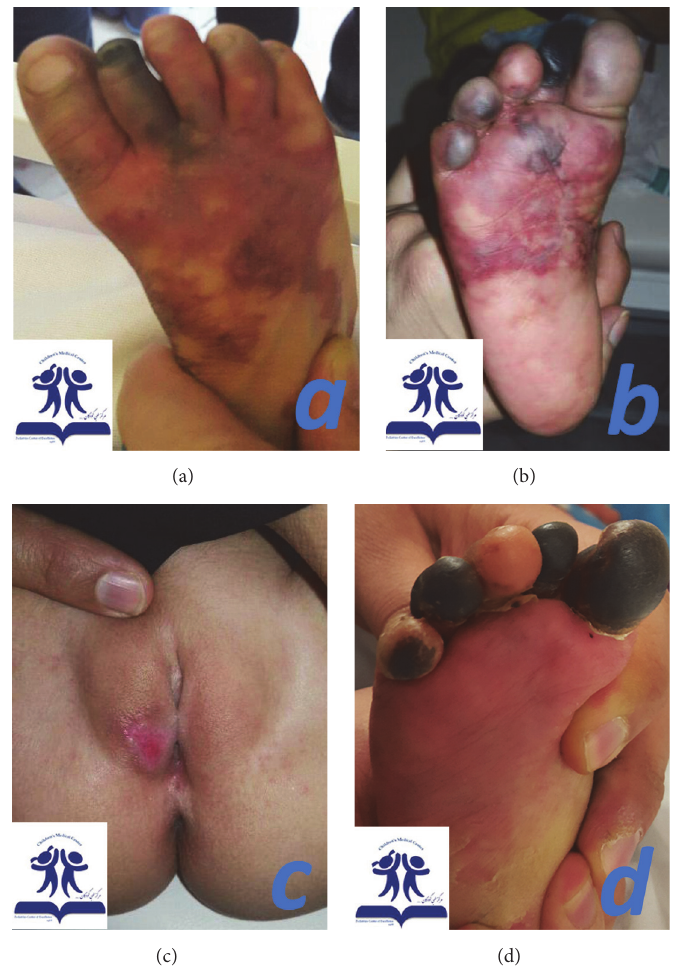
Figure 1: A 2-year-old girl with Nicolau syndrome after injection of benzathine penicillin. (a) The right leg and foot are pale and mottled with ecchymosis and the necrosis of the second toe. (b) Mottling and ecchymosis of the plantar surface and toes of the right foot and the necrotic toes. (c) A round ulcer with about 2-centimeter diameter, on the right labia major. (d) At 2 months’ follow-up improvement of the skin ecchymosis was noticed, but a persistent necrosis lesion in the distal phalanges of some of the toes appeared.